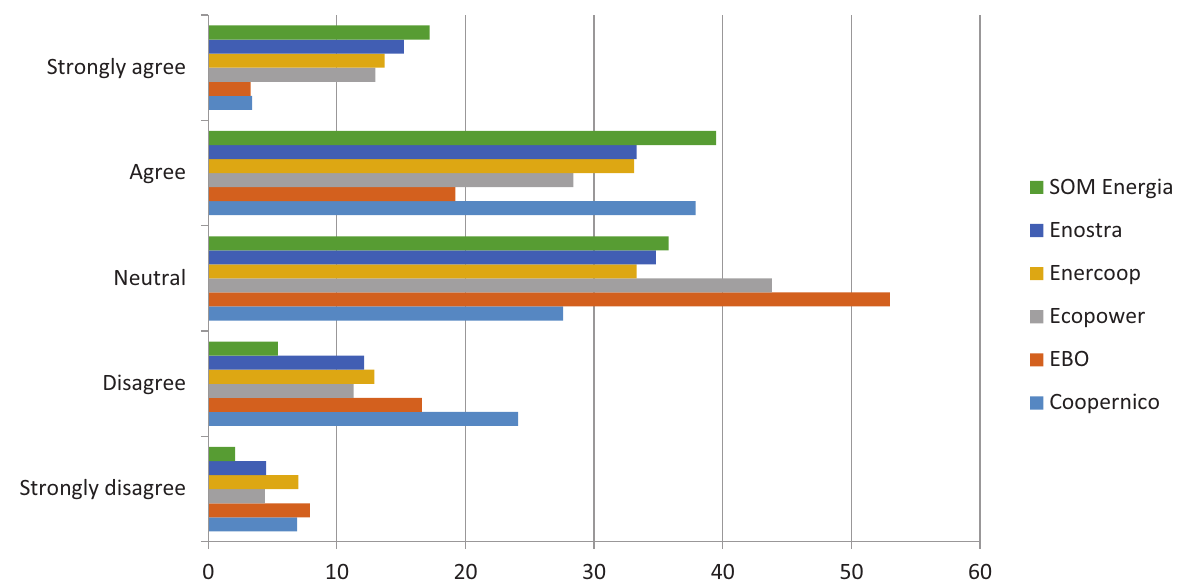
Figure 3. Response, in %, to the 2018 survey item “After having joined a REScoop, energy savings have become more impor‐ tant to me” by REScoop.